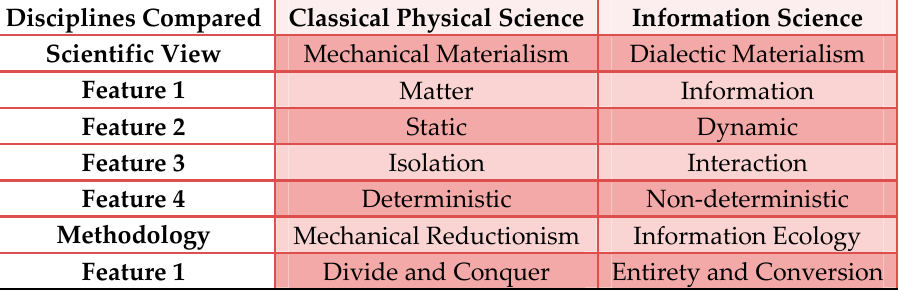
Table 1. Brief Comparison between the Scientific Views and